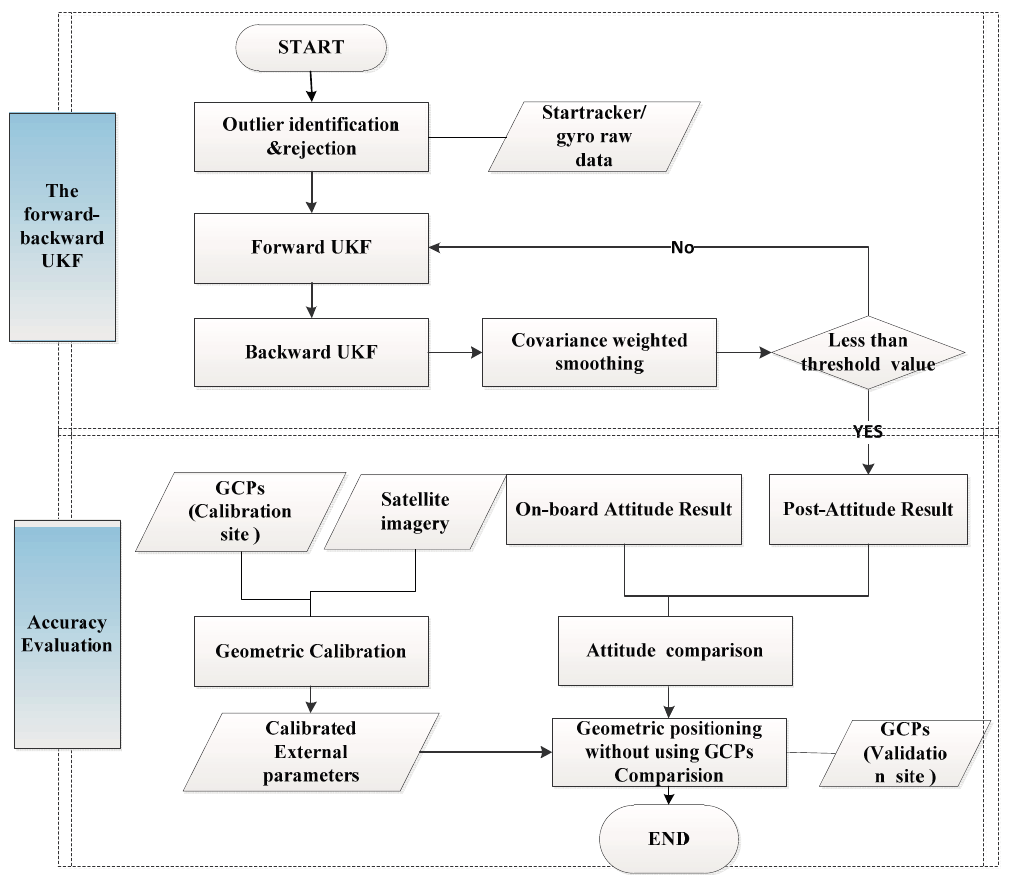
Figure 3. The attitude post-processing and accuracy verification